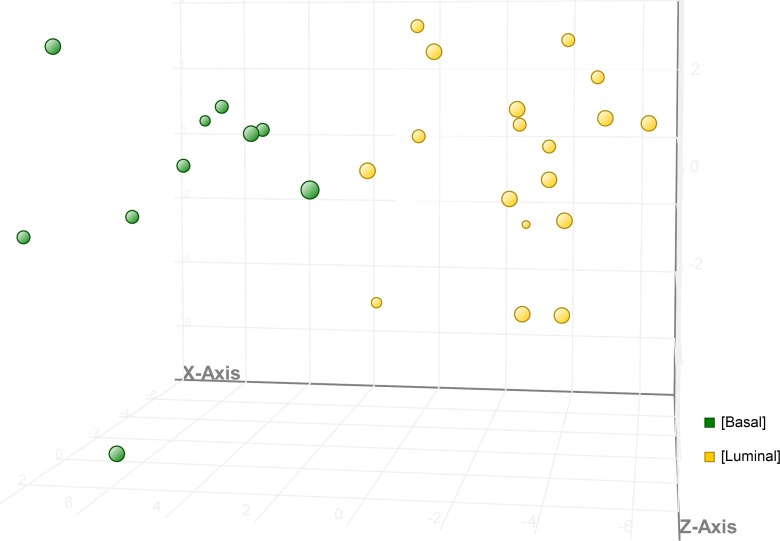
Class prediction model using a panel of genes selected to segregate canine iUC into basal and luminal subtypes.A smaller panel of genes of importance in characterizing basal or luminal subtypes in human iUC was used to develop a class prediction model using Support Vector Machine (SVM) alogrithm and using validation parameters with 100,000 iterations and using validation type “Leave One Out” to generate the validation algorithm outputs. This allowed the selection of a group of genes (n = 60) which could be used to assign canine iUC samples to luminal or basal subtypes. The PCA plot depicts the segregation of tumors as identified by SVM. Of particular interest are genes also implicated in human iUC such as PPARG, CTSF, LY6E, VGLL1, SERPINE2, SULT1A1, and CAV1.